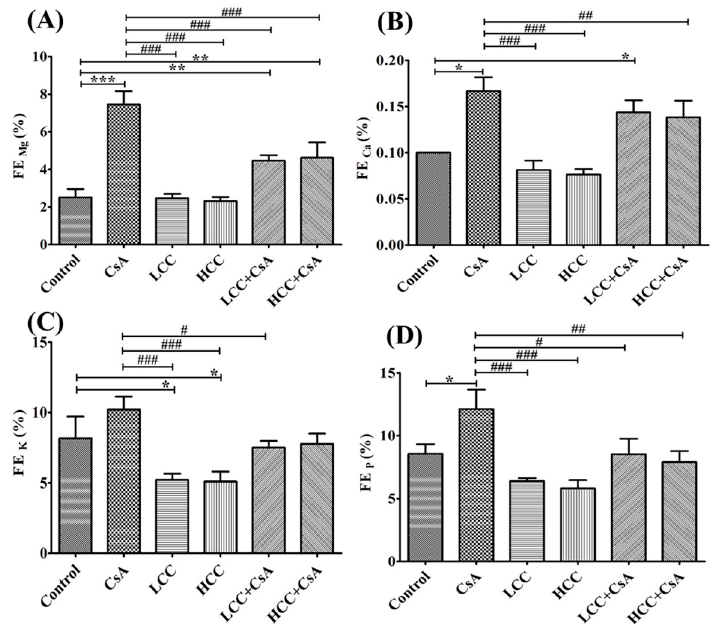
Figure 3. Effects of cyclosporine A (CsA) and CCM treatment on fractional excretion (FE) of Mg ( A ), Ca ( B ), K ( C ), and P ( D ) ions in serum. Control, CsA (10 mg/kg), LCC (40 mg/kg), HCC (400 mg/kg), LCC (40 mg/kg) + CsA (10 mg/kg), and HCC (400 mg/kg) + CsA (10 mg/kg). Values are expressed as the mean ± SEM (n = 6). One-way ANOVA is followed by the Fisher’s LSD tests. * p < 0.05, ** p < 0.01, and *** p < 0.001 vs. control. # p < 0.05, ## p < 0.01 and ### p < 0.001 vs. CsA group.